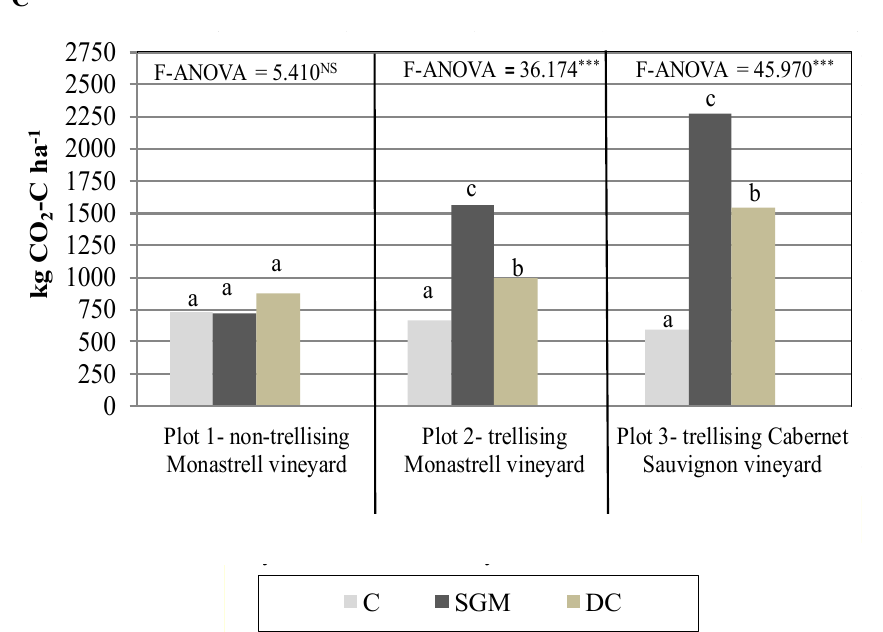
Figure 7. Cumulative N 2 O ( A ), CH 4 ( B ) and CO 2 ( C ) emissions. In each plot, bars with the same letter are not significantly different at p < 0.05 (Tukey-b test). ** and ***: Significant at p < 0.01 and 0.001, respectively. NS : not significant (C: control, SGM: sheep/goat manure and DC: distillery organic waste compost).